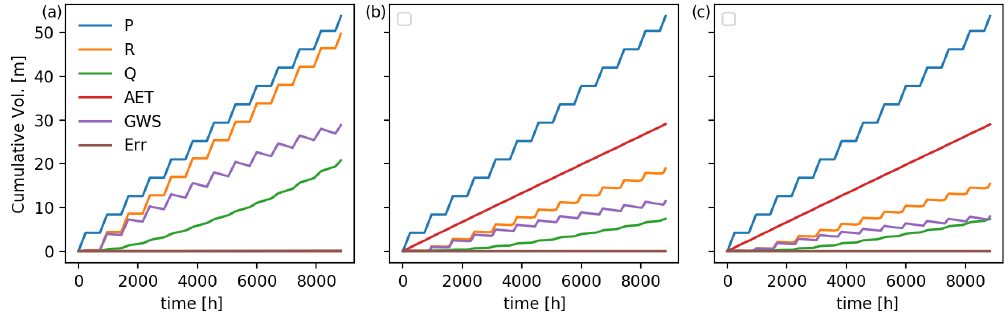
Figure 8. Cumulative volume of the main components of the water balance for the simulated scenarios: (a) infiltration–discharge, (b) infiltration–evapotranspiration–discharge, and (c) infiltration–runoff–evapotranspiration–discharge. P is the precipitation, R is recharge, Q is discharge at the catchment outlet, AET is actual evapotranspiration, GWS is the change in groundwater storage, and Err is the water balance error of the simulation.